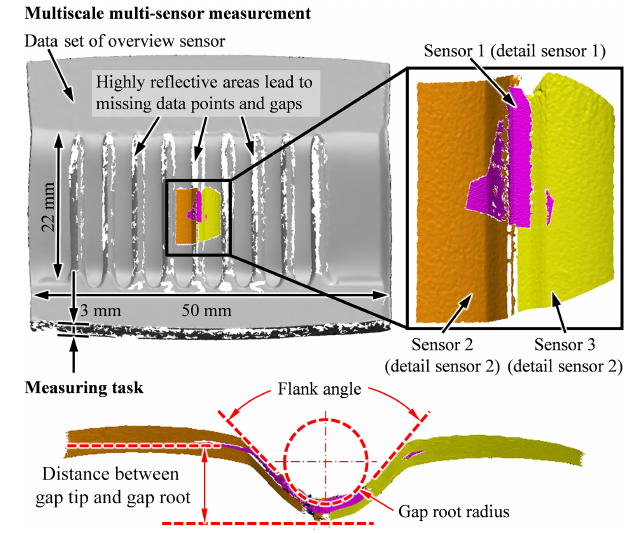
Figure 9. Multi-scale multi-sensor measurement of a sheet-bulk metal-formed multiple gap structure (upper side) and the corre- sponding measuring task (lower side).